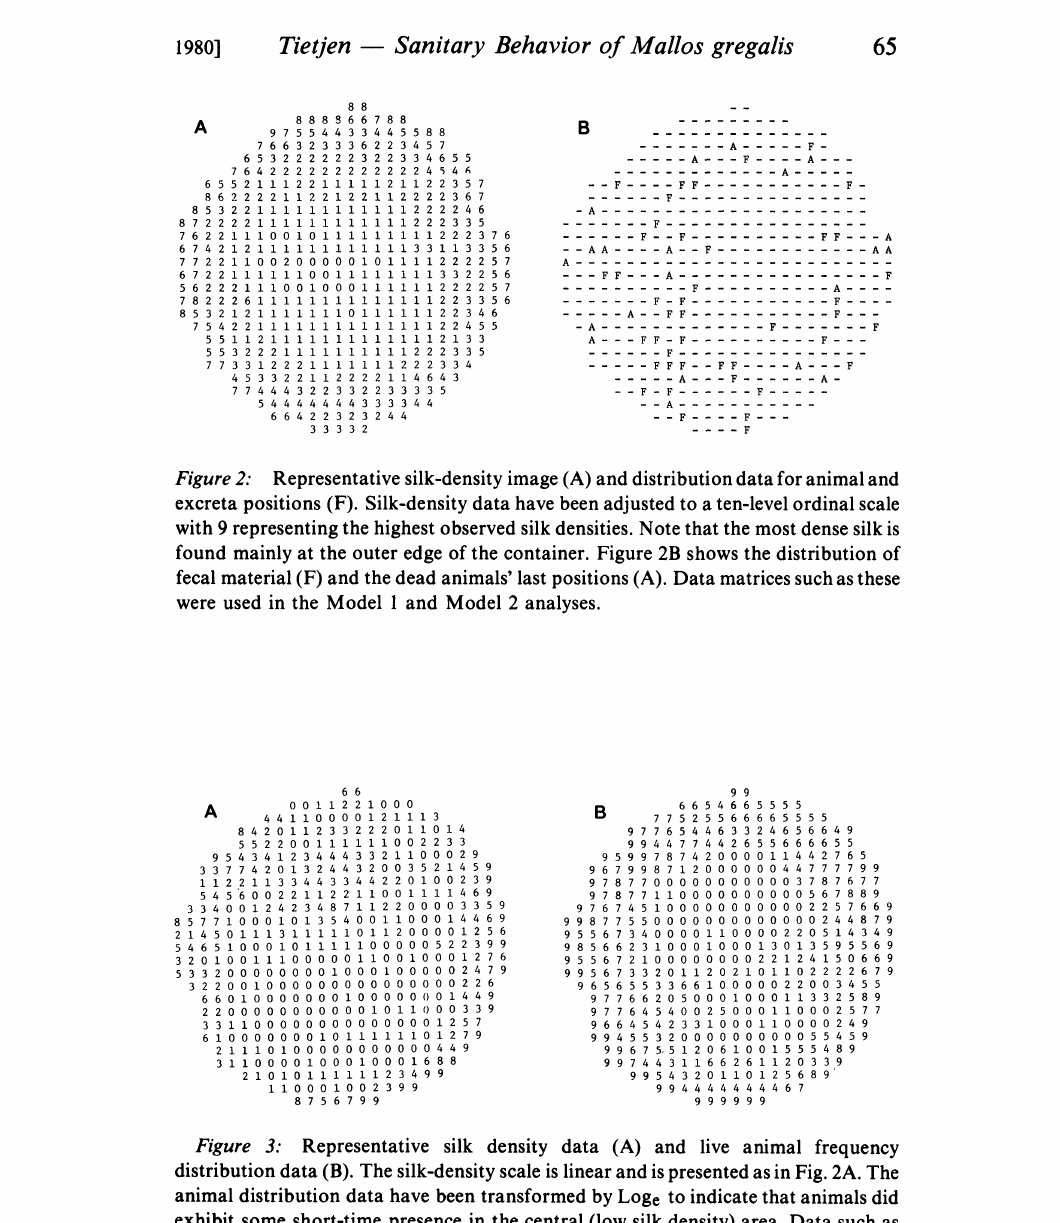
Figure 3: Representative silk density data (A) and live animal frequency distribution data (B). The silk-density scale is linear and is presented as in Fig. 2A. The animal distribution data have been transformed by Loge to indicate that animals did exhibit some short-time presence in the central (low silk density) area. Data such as these were used in the Model 3